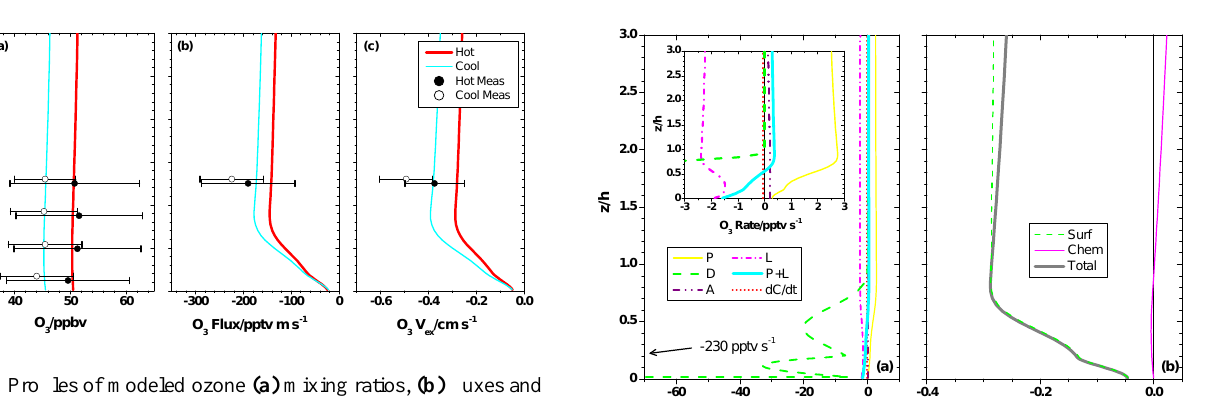
Fig. 5. Profiles of modeled ozone (a) mixing ratios, (b) fluxes and (c) exchange velocities for the hot and cool periods. Filled and open circles represent observations (mean ± standard deviation) for the hot and cool periods, respectively. Cool period observations are offset on the y-axis for clarity. To convert O 3 fluxes from chemical units (pptv m s − 1 ) to depositional units (µmol m − 2 h − 1 ) , multiply by 0.125.